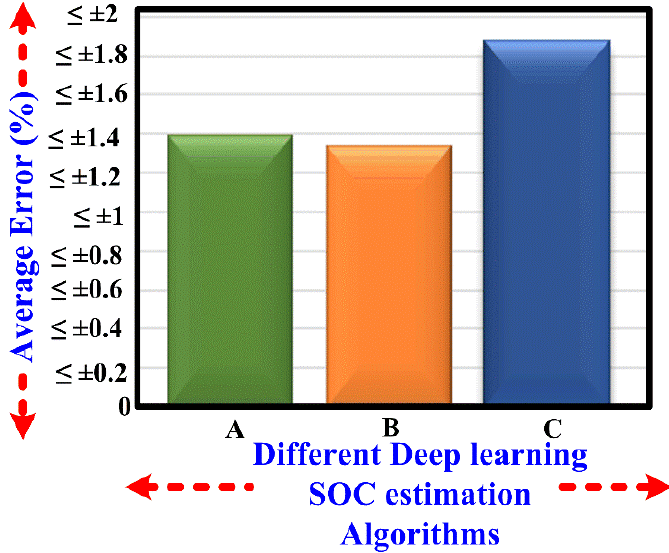
Figure 13. Comparison between the different nonlinear observer SOC estimation methods. “A” is referred to as [110], and “B” is referred to as [131].